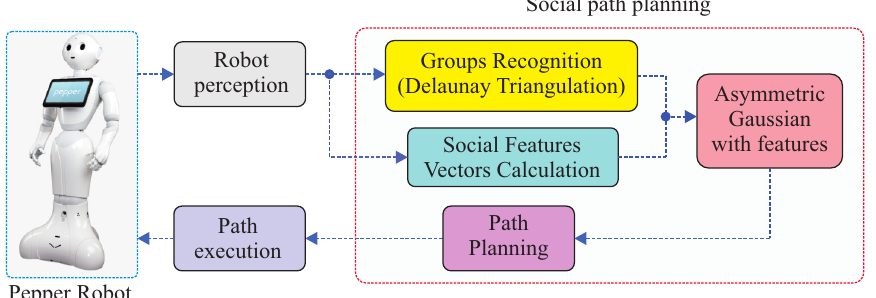
Figure 3. Social path planning using the proposed method.